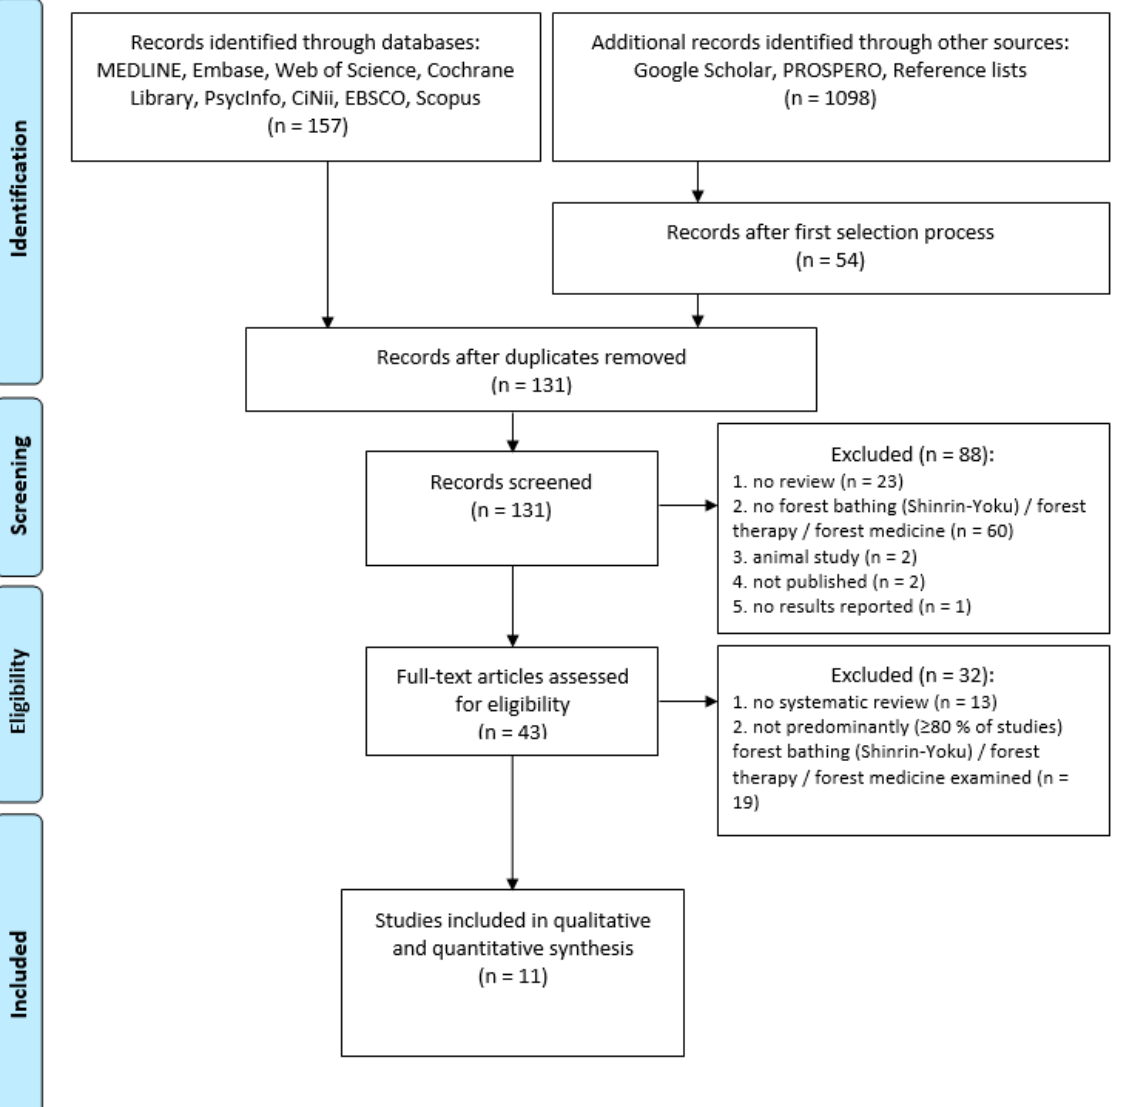
Figure 2. PRISMA (Preferred Reporting Items for Systematic Reviews and Meta-Analyses) flow chart for the selection of reviews [37].